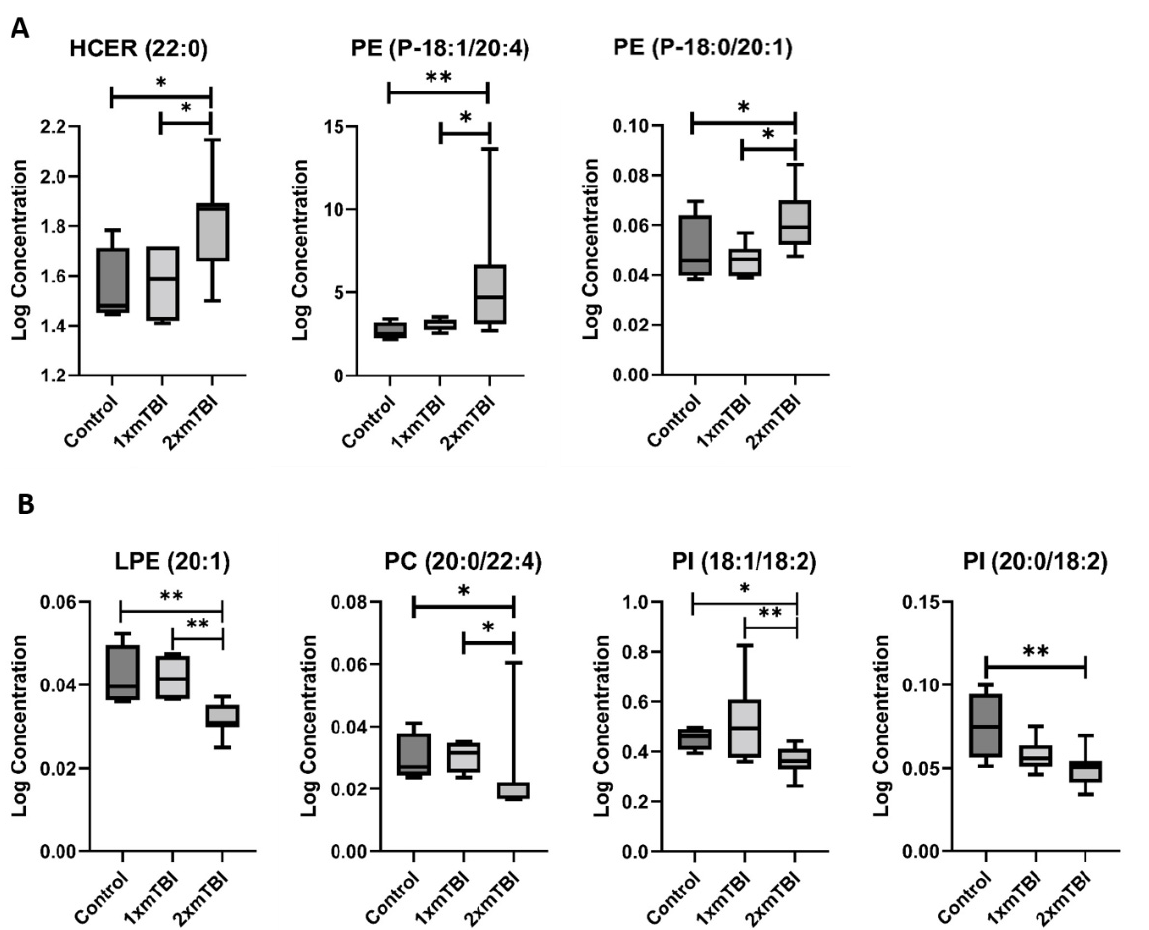
Figure 4. Lipids that change with two injuries vs. sham control. ( A ), Increase after 2 × mTBI; ( B ), decrease after 2 × mTBI. Boxplots represent the minimum, first quartile, median, third quartile, and maximum, for the control, 1 × mTBI and 2 × mTBI groups. Significant differences between groups are indicated above the boxplots by * ( p < 0.05) or ** ( p < 0.01). HCER, hexosylceramide; LPE, lysophosphatidylethanolamine; mTBI, mild traumatic brain injury; PC, phosphocholine; PE, phosphoethanolamine; PI, phosphoinositol.